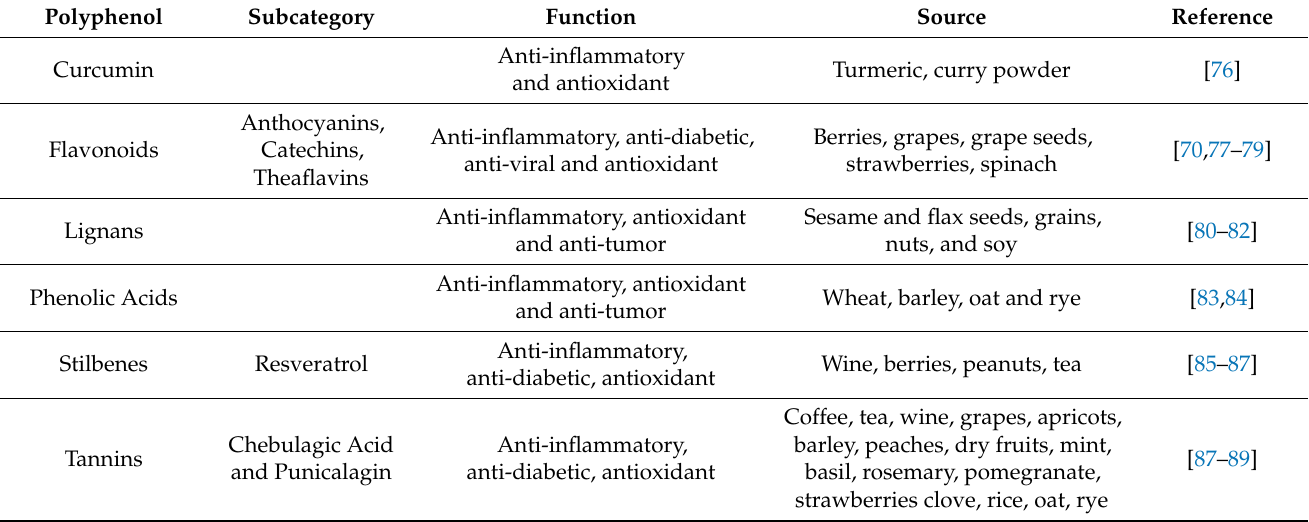
Table 2. Plant polyphenols and human health. This table summarizes the role of various polyphenols in human health and the most common foods rich in specific